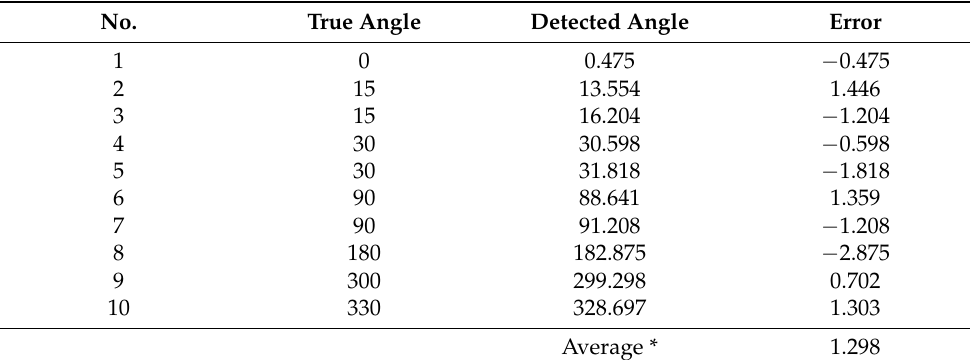
Figure 21. Bolt loosening angle detection visualization ( a ) Bolt in the tight state; ( b ) Bolt of the current state. Table 7. Bolt loosening angle detection